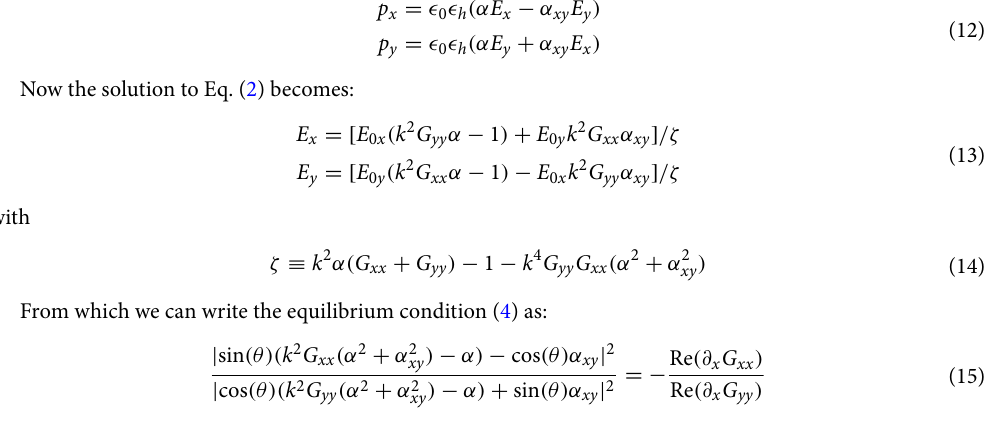
Figure 4. Dipole’s angle with respect to the dimer’s axis ( β ) versus interparticle distance for different light polarization angles ( θ ). Wavelength is set to 340 nm. Black continuous line marks the dipoles angle at which zero bonding force is expected within the near field approximation. In the far field region β (bonding state) but, as the nanoparticles approach each other, β increases. For a particular distance depending arctan ( √ 2 ) and the bonding force vanishes. This is the expected equilibrium binding distance within on θ , β = the near field approximation. As nanoparticles get closer, β > arctan ( √ 2 ) and the anti-bonding repulsion force emerges. Insets show a cartoon of the dipole’s